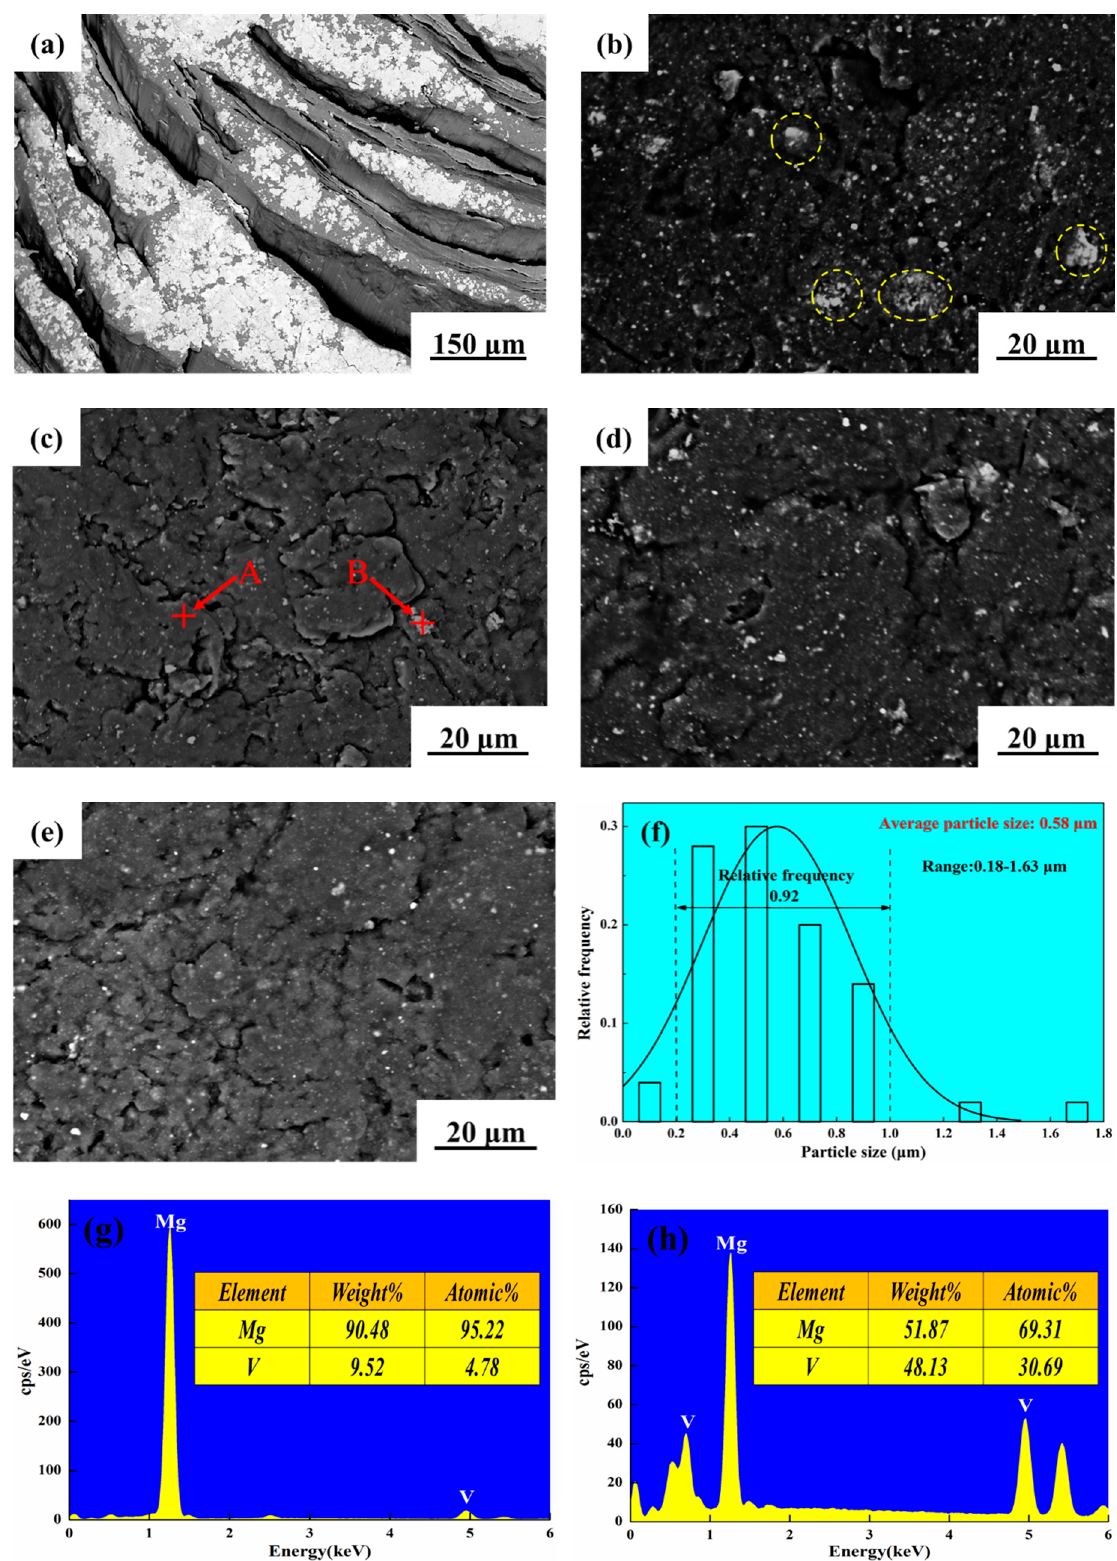
Figure 10. The BSE images of AZ31 ‐ 5 wt % V P powders milled for different times: ( a ) 10 h, ( b ) 30 h, ( c ) 50 h, ( d ) 70 h, ( e ) 90 h, ( f ) particle size distribution map of V P after milling for 90 h, ( g , h ) EDS results of point A and B.